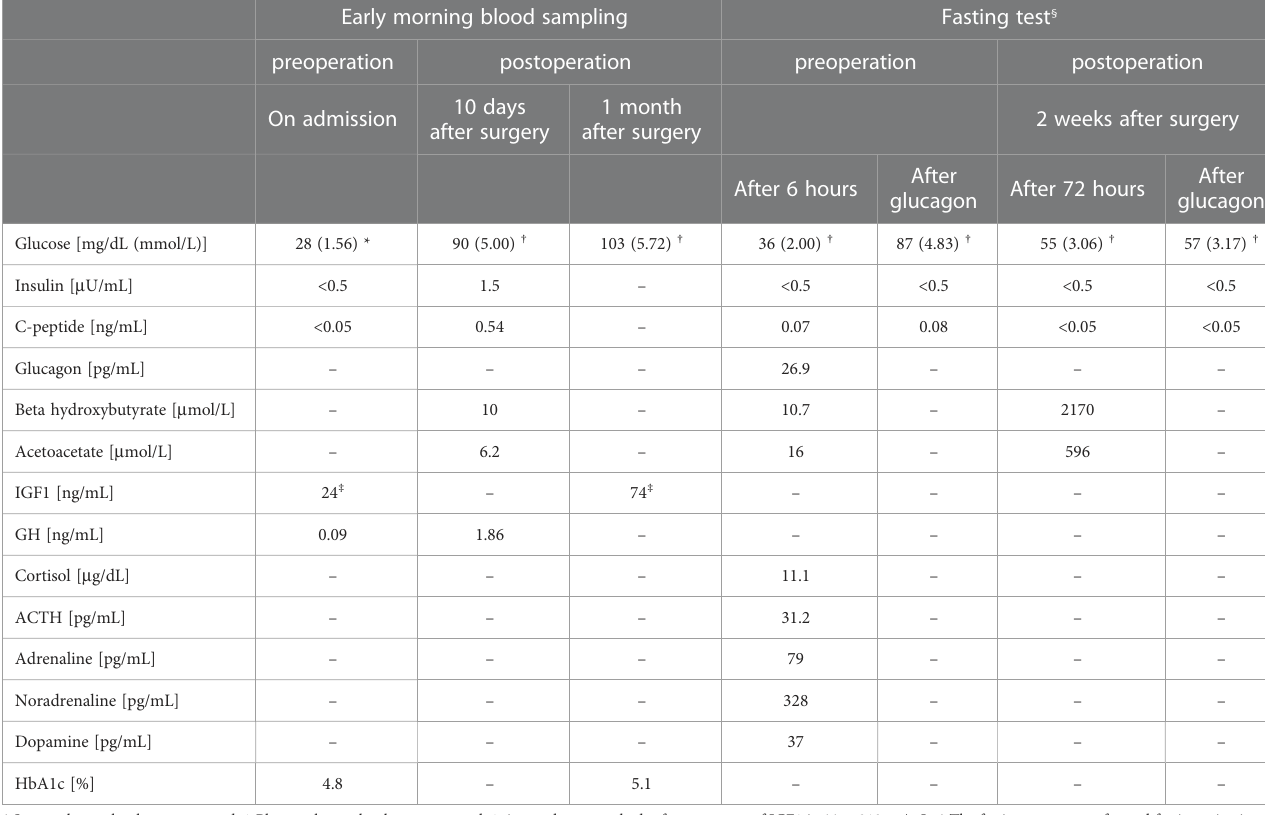
TABLE 1 Pre- and postoperative laboratory